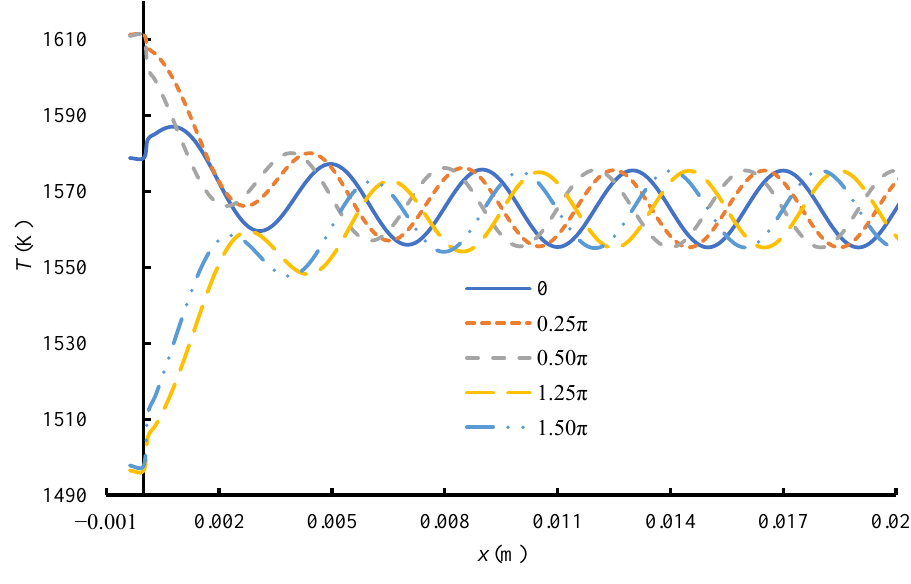
Figure 10. Pt wire temperature profiles with different gas temperature phases. Overall, the amplitude, wavelength and phase of the gas temperature have little effect on the effective length. The effective length is mainly determined by the thermocouple parameters, such as the conductivity, the size and the heat transfer coefficient of the wire. As such, using the theoretical expression of the uniform incoming temperature should be result in calculating the effective length with good accuracy.